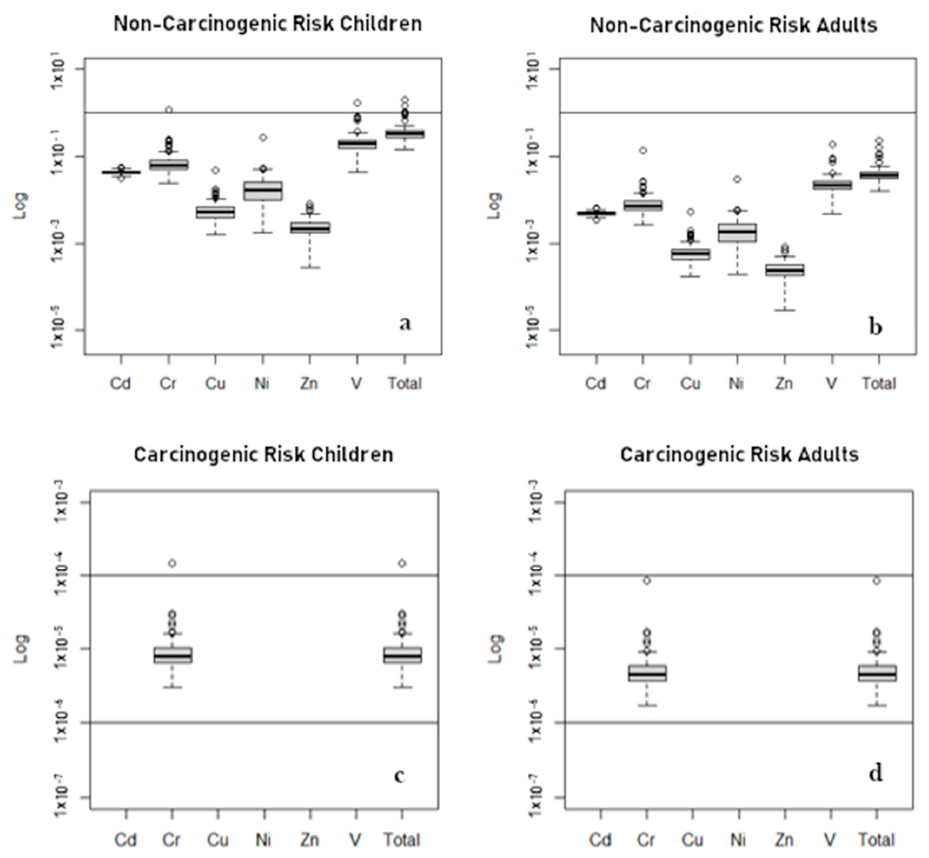
Figure 6. Carcinogenic and non-carcinogenic risk in children and adults. ( a ) Non-Carcinogenic Risk Children, ( b ) Non-Carcinogenic Risk Adults, ( c ) Carcinogenic Risk Children and ( d ) Carcinogenic Risk Adults.